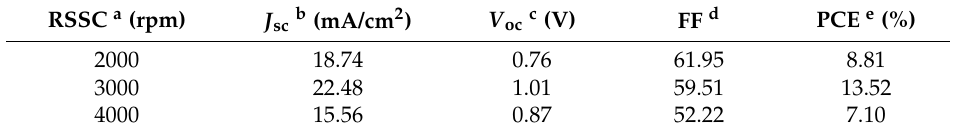
Table 2. Summary of J – V characteristics from reverse scan of the PSC devices based on TiO 2 /SnO 2 complementary composite hole blocking layer under different SnO 2 spin ‐ coating speeds.